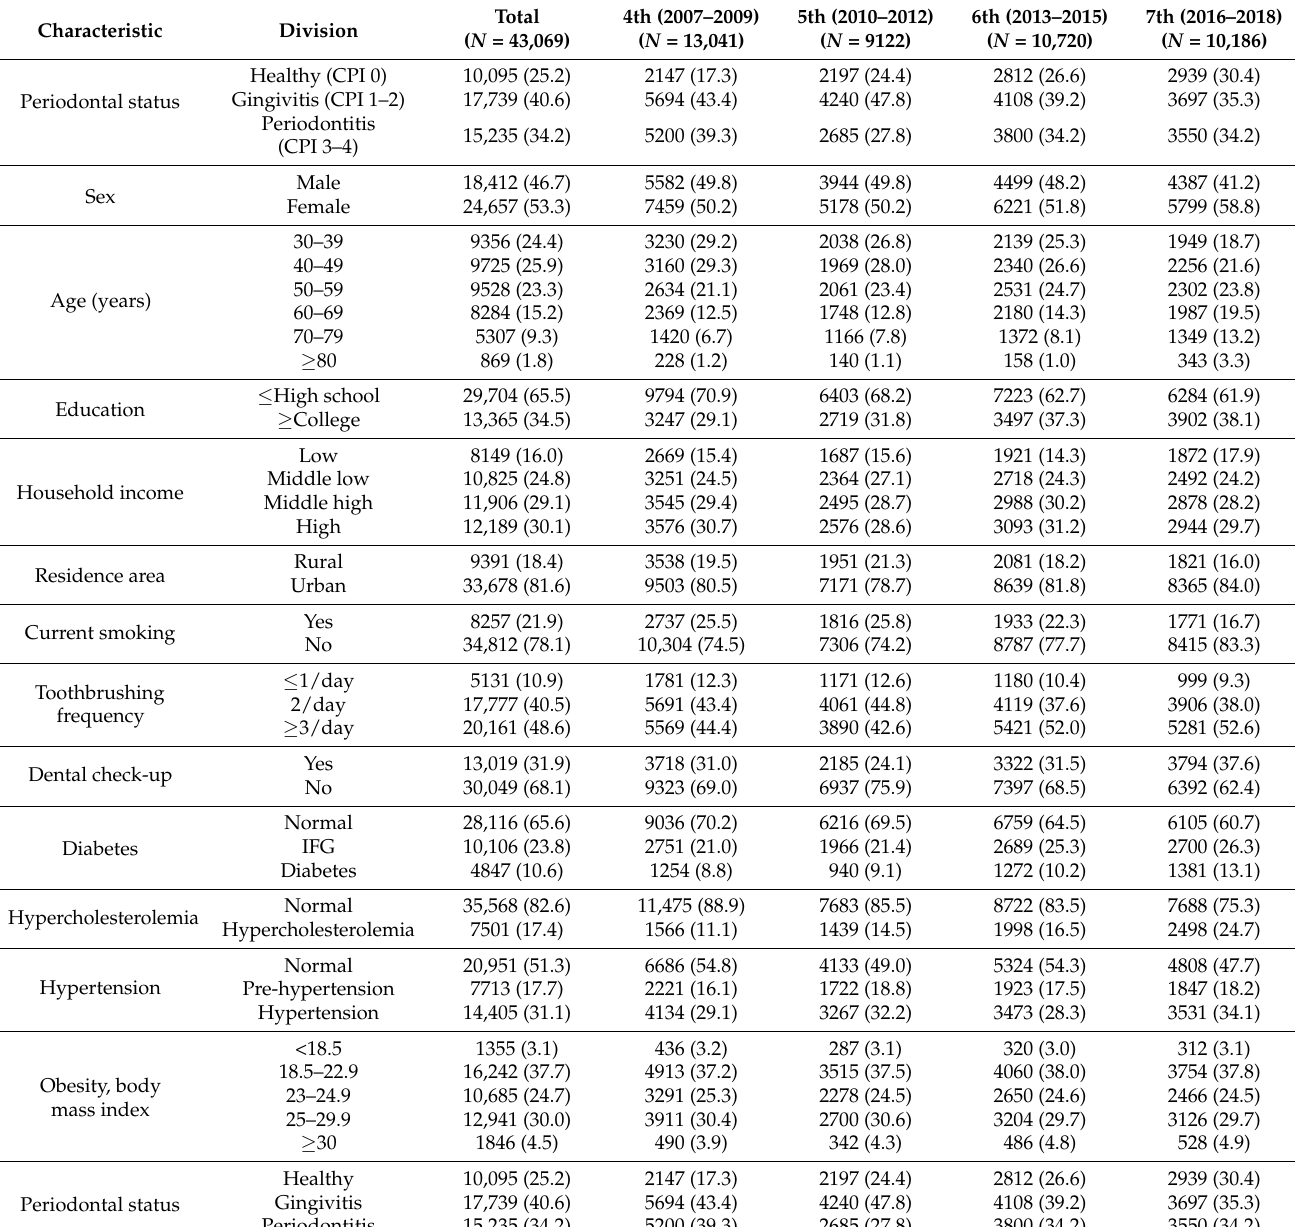
Table 1. Characteristics of the study population according to KNHANES